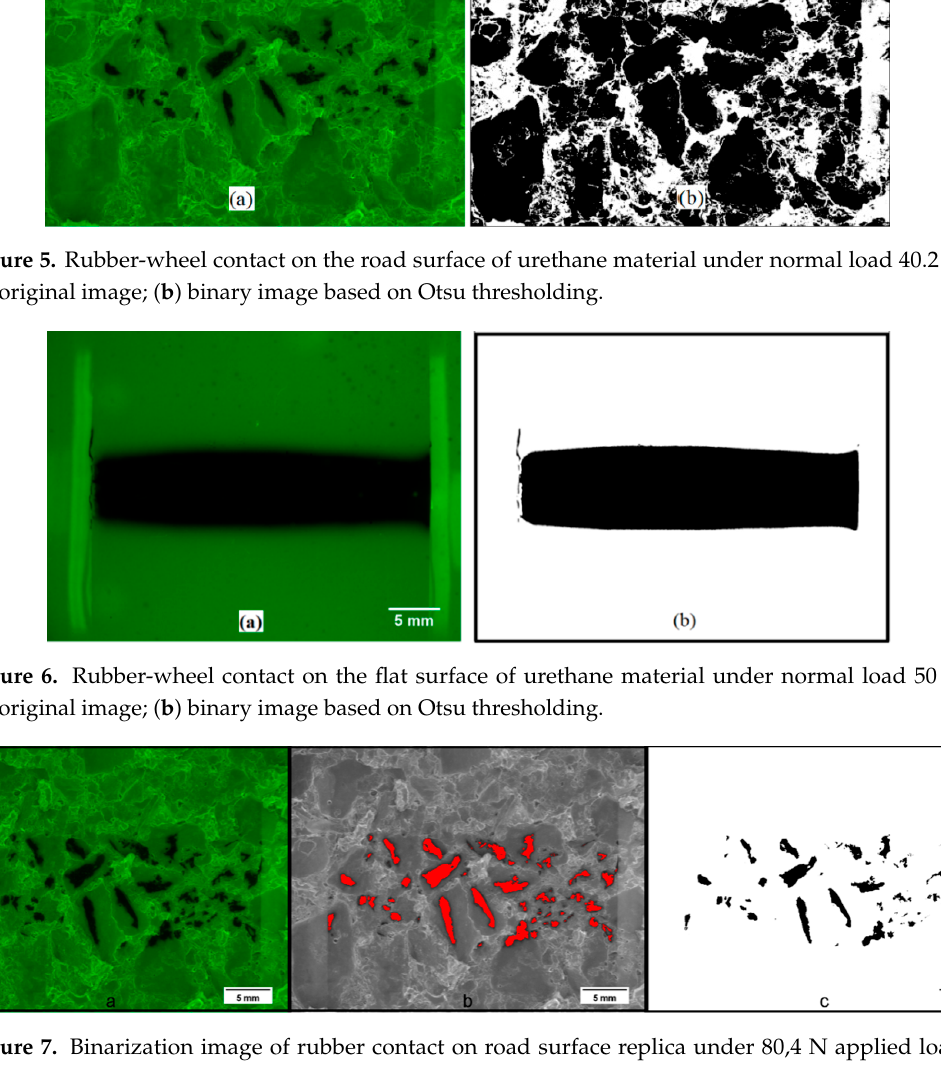
Figure 7. Binarization image of rubber contact on road surface replica under 80,4 N applied load: ( a ) original image, ( b ) red binary with road replica background, ( c ) black and white binary image.